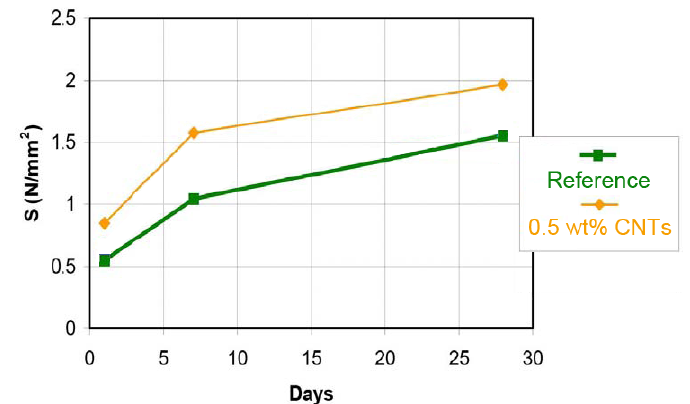
Figure 10: Mean dissipated energy in function of the curing